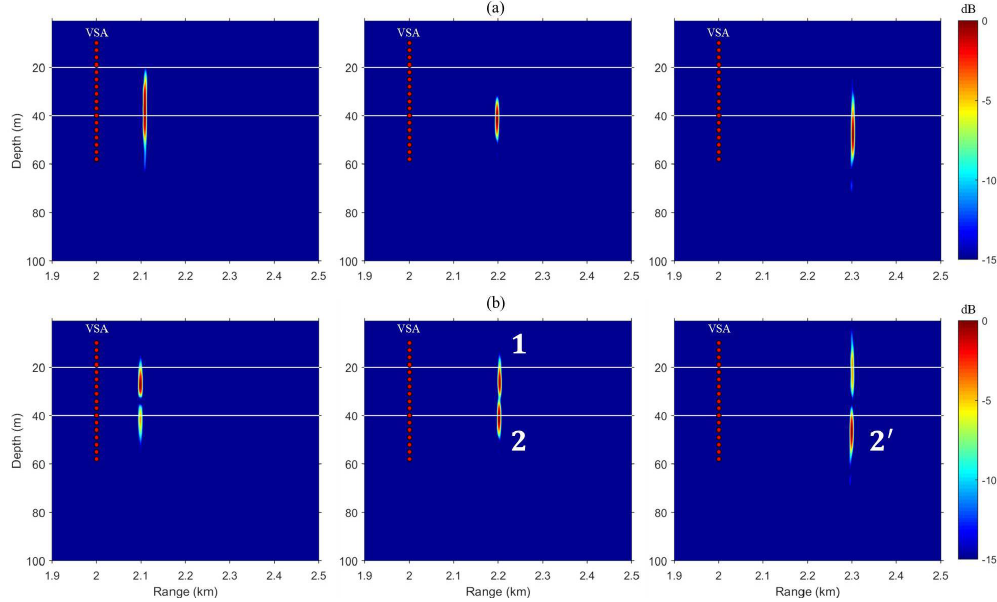
Figure 9. (Color online) Comparison of VSA-based single TR focusing and VSA-based multiple TR focusing using SVD method in sound speed mismatch environment. Each panel represents a backpropagated field corresponding to a different single snapshot time. Selected locations are (cid:126) r (cid:126) r s 2 = (2.3 km, 40 m). ( a ) VSA-based single TR focusing; ( b ) VSA-based multiple s 1 = (2.2 km, 20 m) and TR focusing using SVD